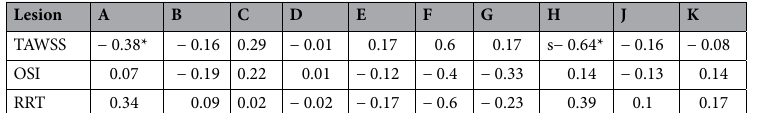
Table 3. Results of the local individual analysis, in which Spearman’s correlation coefficients between hemodynamic descriptor and lumen area change are shown for each lesion and for each hemodynamic descriptor. Bold indicate significant statistical results. *p <